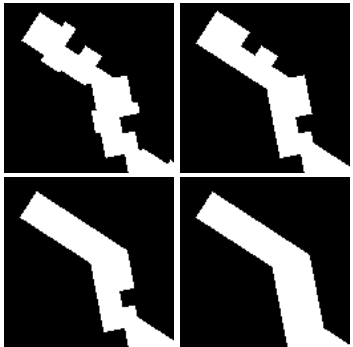
Figure 6. Example of one 128px × 128px map tile from OSM ( upper left ), at scale 1:10,000 ( upper right ), 1:15,000 ( bottom left ), and 1:25,000 ( bottom right